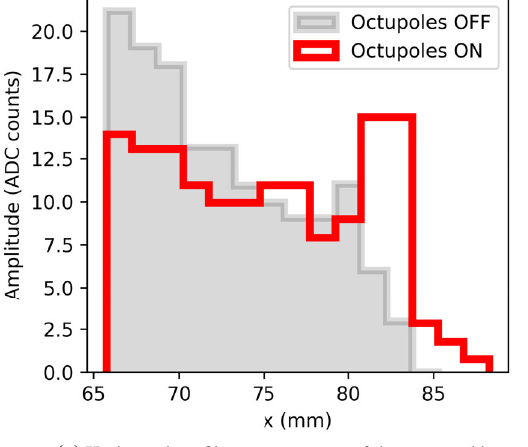
FIG. 15. Trapped beam intensity circulating at the end of the flat-top, and subsequently dumped, as a function of the LOF strength, with the TCSM aligned at the equivalent aperture of the ZS wire-array. The shaded regions identify the parameter space to be avoided to protect the wire-arrays of the ZS from the risk of trapping at large amplitude.